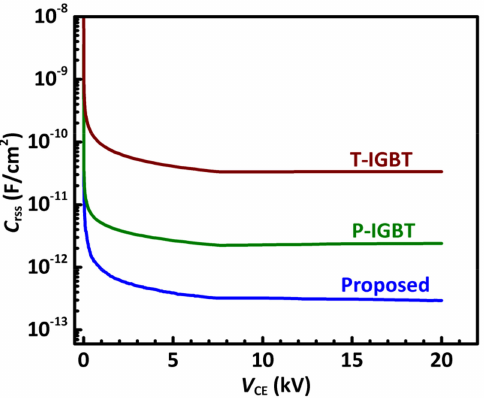
Figure 7. Reverse transfer capacitance ( C rss ) of the studied P-IGBT, T-IGBT, and the proposed SiC